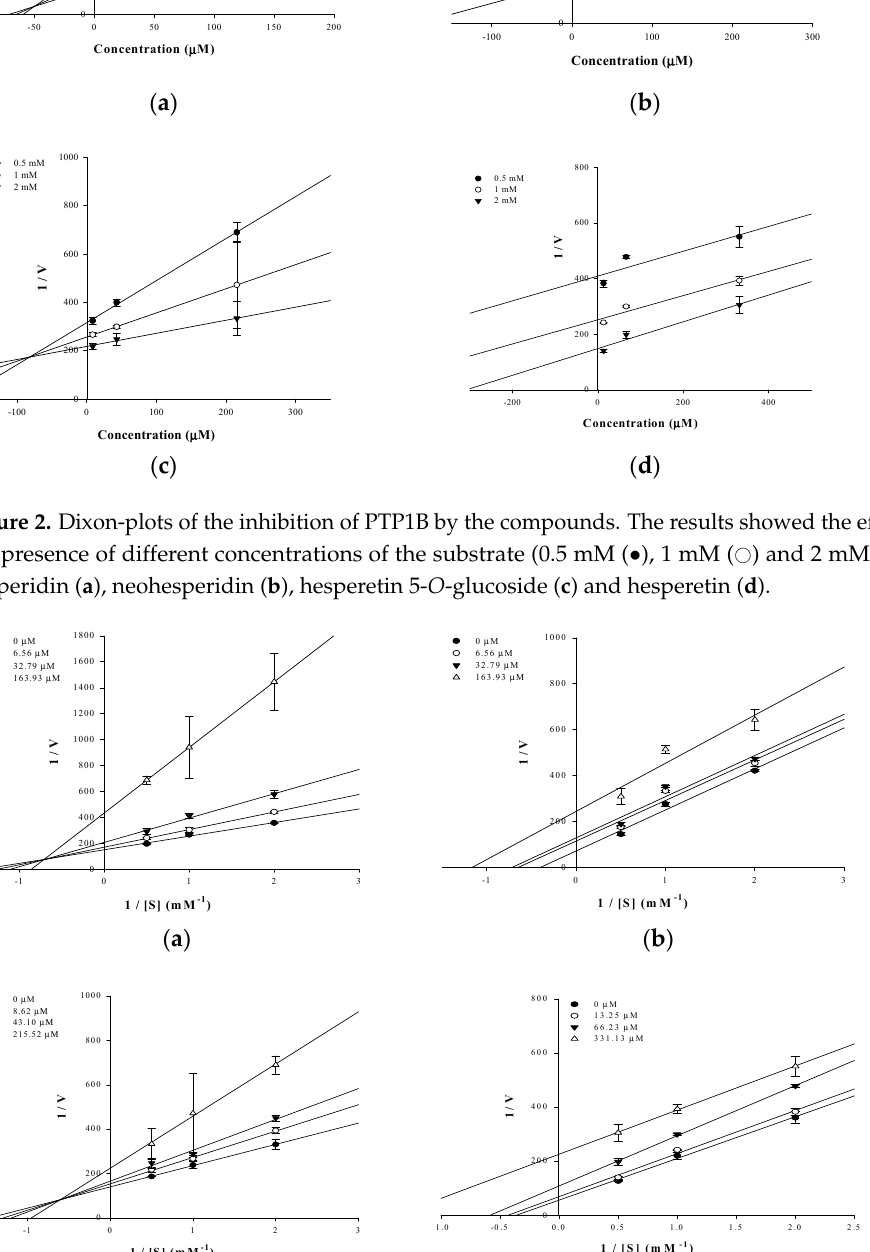
Figure 3. Lineweaver–Burk plots for the inhibition of PTP1B by the flavonoids. The results showed the effects of the presence of di ff erent concentrations of the fl avonoids (0 µM ( ● ), 6.56 µM ( ○ ), 32.79 µ M ( (cid:72) ) and 163.93 µ M ( (cid:52) ) for hesperidin ( a ) and neohesperidin ( b ); 0 µ M ( • ), 8.62 µ M ( 43.10 µ M ( (cid:72) ) and 215.52 µ M ( (cid:52) ) hesperetin 5- O -glucoside ( c ) and 0 µ M ( • ), 13.25 µ M ( ( (cid:72) ) and 331.13 µ M ( (cid:52) ) hesperetin ( d